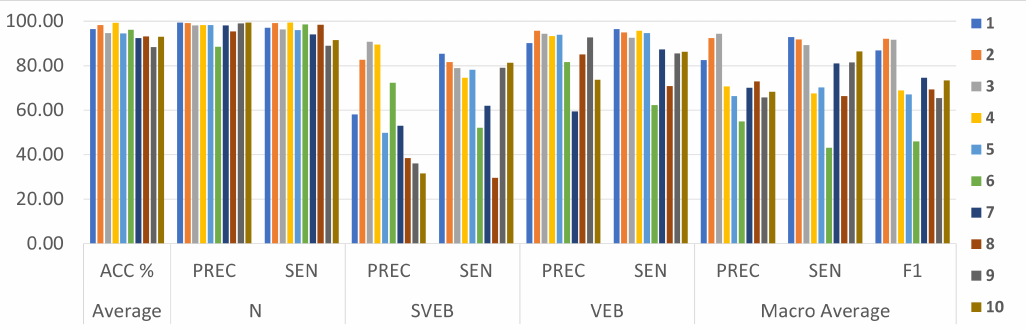
Figure 6. Comparison between the proposed MF model and related models of Table 5.